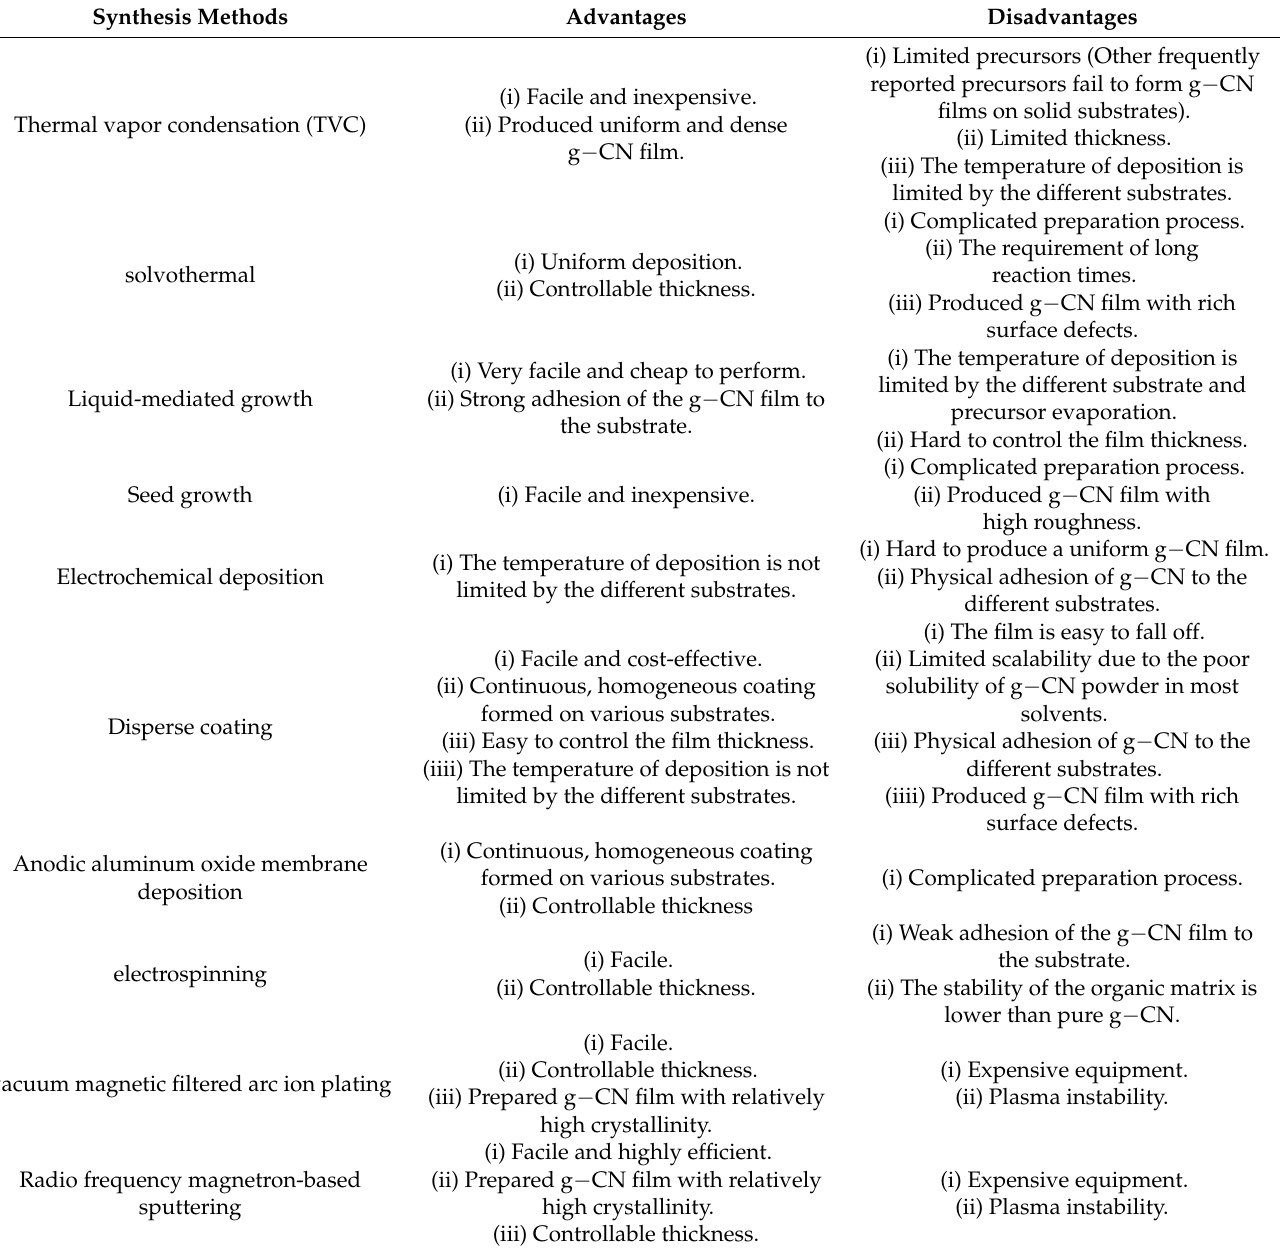
Table 1. The main advantages and disadvantages comparison of different